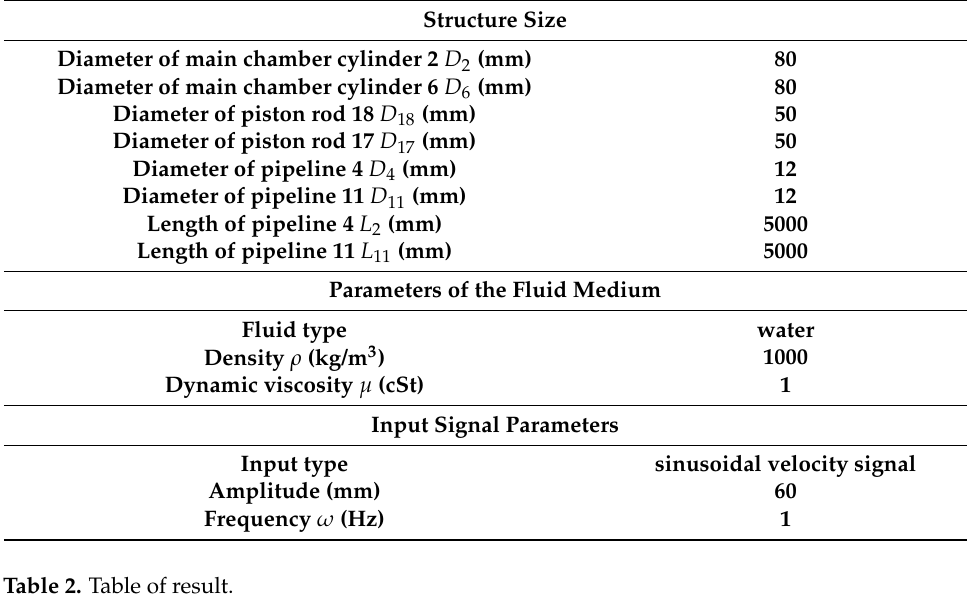
Table 1. Table of structure and fluid parameters of the single-cylinder fluid inerter.